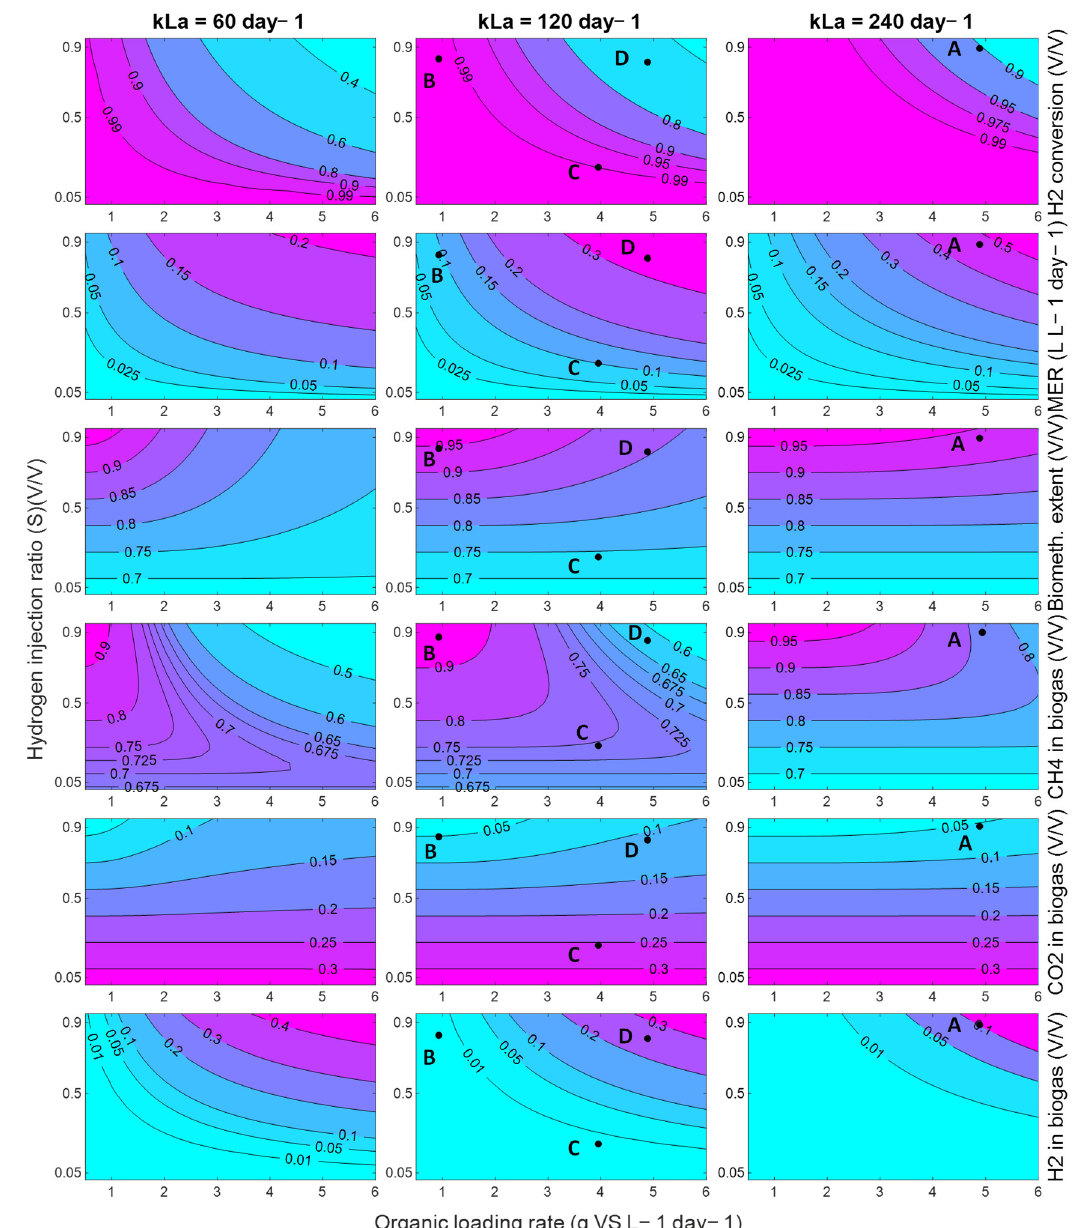
Figure 15. Contour plots of in-situ biomethanation performance using SS with a variation in the OLR and hydrogen injection ratio for k L a of 60, 120, and 240 day − 1 . Labelled points (A, B, C, D) on the plots refer to alternative process conditions and are elaborated in the discussion.